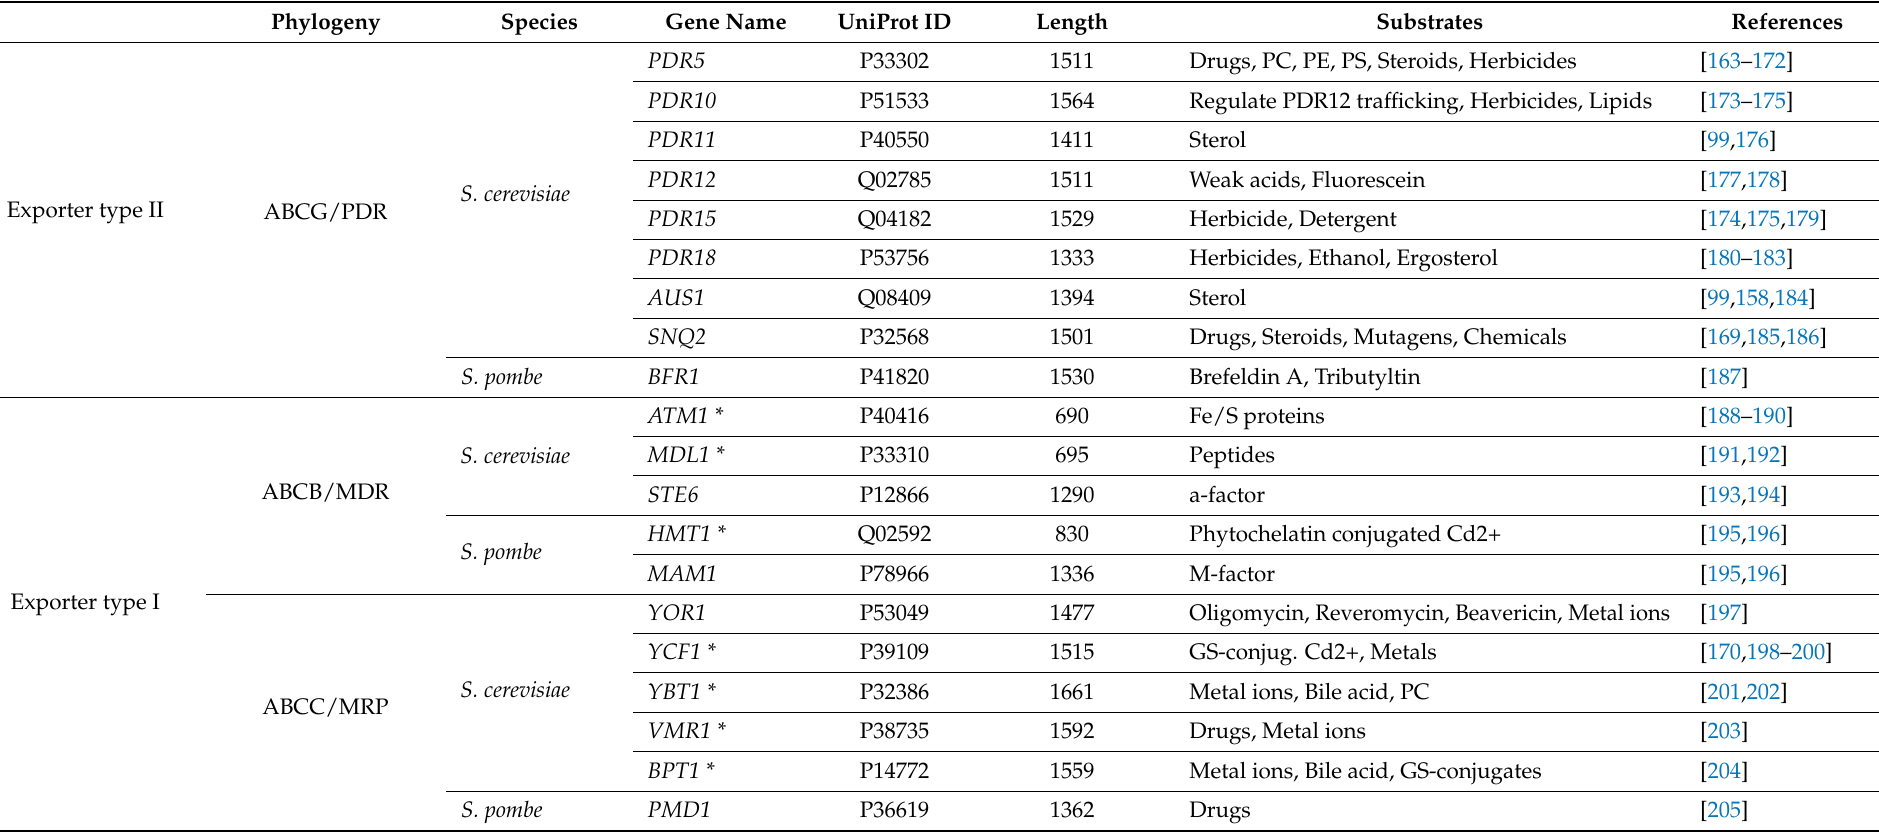
Table 1. Known ABC transporters in non-pathogenic